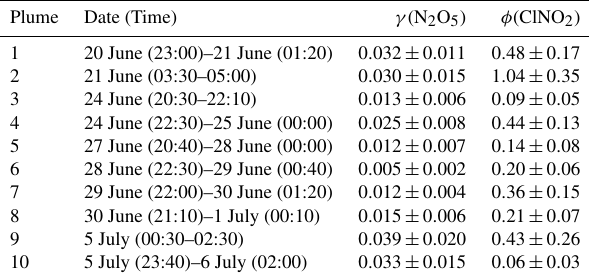
Table 1. N 2 O 5 uptake coefficients and ClNO 2 production yields from 10 selected plumes at Wangdu during the summer of 2014. The uncertainty ( ± ) in the γ (N 2 O 5 ) and φ was estimated by the geometric mean of uncertainty from the scattering of the data plots and uncertainty from the measurement of N 2 O 5 , ClNO 2 , aerosol surface area, and total NO − 3